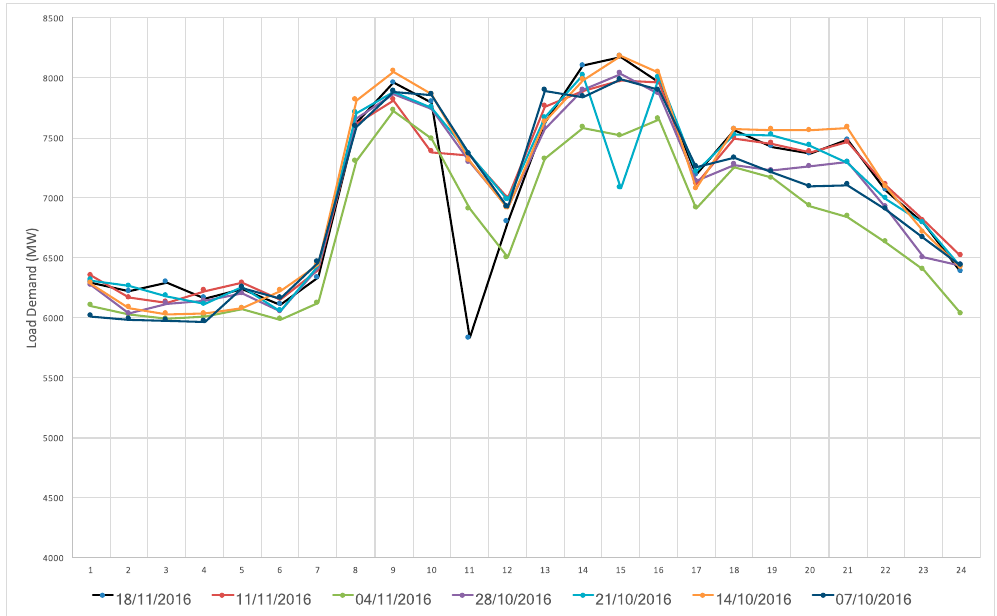
Figure 14. The comparison between Fridays of October and November on Hourly Load Pattern.